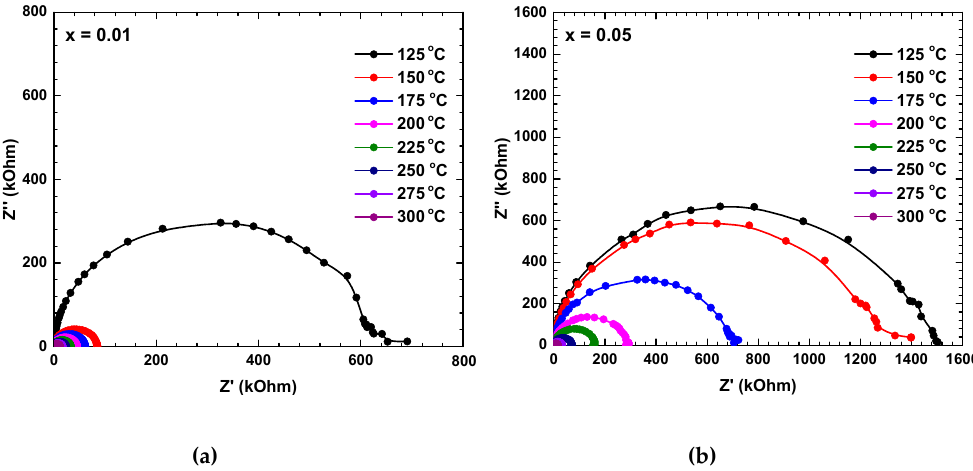
Figure 4. Nyquist plots of LaFe 1 − x Zr x O 3 with ( a ) x = 0.01 and ( b ) x = 0.05 annealed at 800 °C for 6 h at different temperatures.